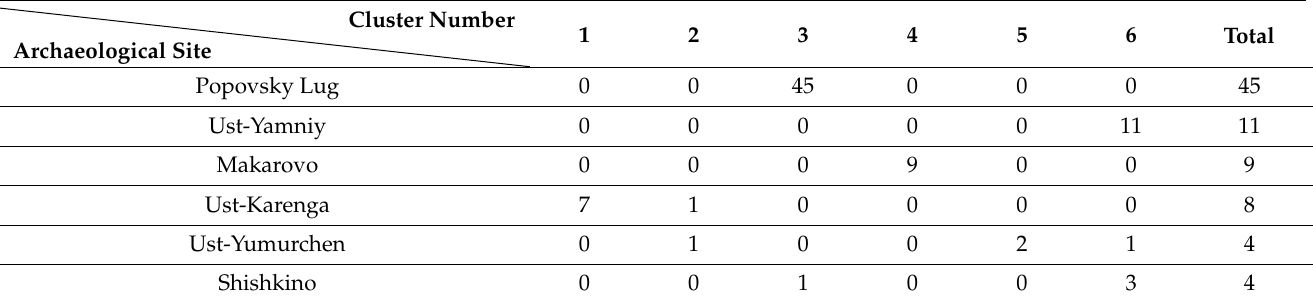
Table 2. Frequency table for cluster analysis of ceramic samples characterized by archaeological site.